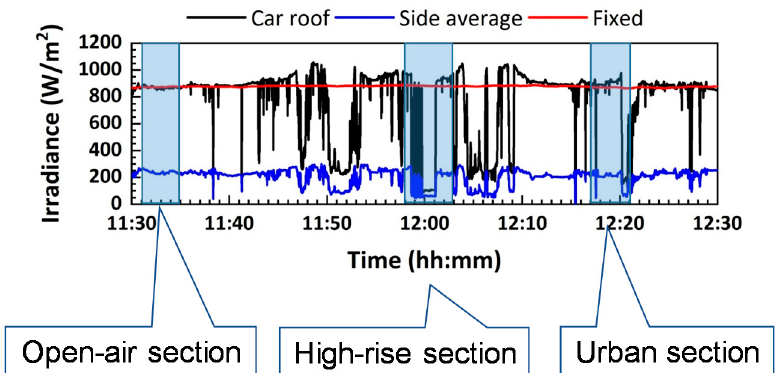
Figure 14. Monitored the result of the solar irradiance on the car roof and car sides in the driving route in Figure 13.